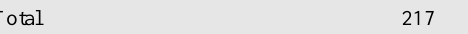
Table 6. Number of storeys.